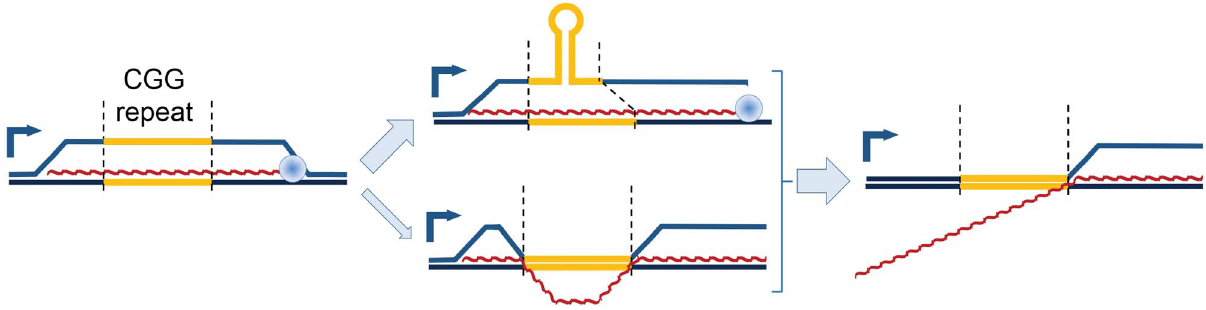
Figure 5. Model of proposed CGG-repeat effects on the FMR1 R-loop. R-loops that span the FMR1 CGG-repeat region (yellow) during transcription could adopt a hairpin structure within the displaced CGG-repeat strand, thus protecting the CGG-repeat region from bisulfite conversion while leaving both 5 9 and 3 9 flanking regions exposed; the CGG-repeat is known to form such structures readily in vitro [61]. An alternative structure, although less energetically feasible, would involve maintenance of R-loops flanking the CGG-repeat element, which has collapsed into a dsDNA structure again. Loss of the upstream R-loop region would explain the absence of bisulfite conversion in , 25–50% of molecules (Figure 4). Red, nascent RNA transcript; 90 u arrow, start of transcription; blue sphere, Pol II.